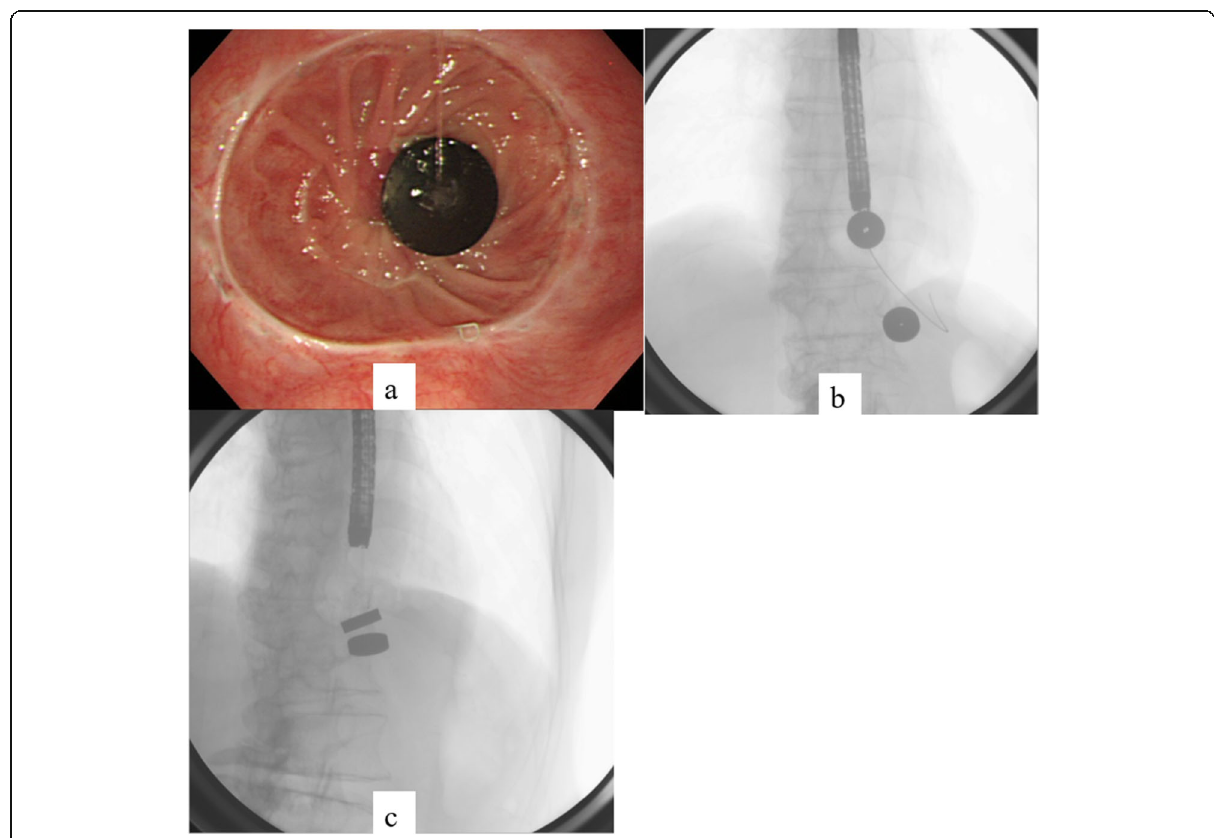
Fig. 4 Magnetic compression anastomosis (placing the daughter magnet on the oral side of the stenosis). a Esophagogastroduodenoscopy. b Radiograph. c Radiograph showing adsorption of the two magnets in the side-to-side